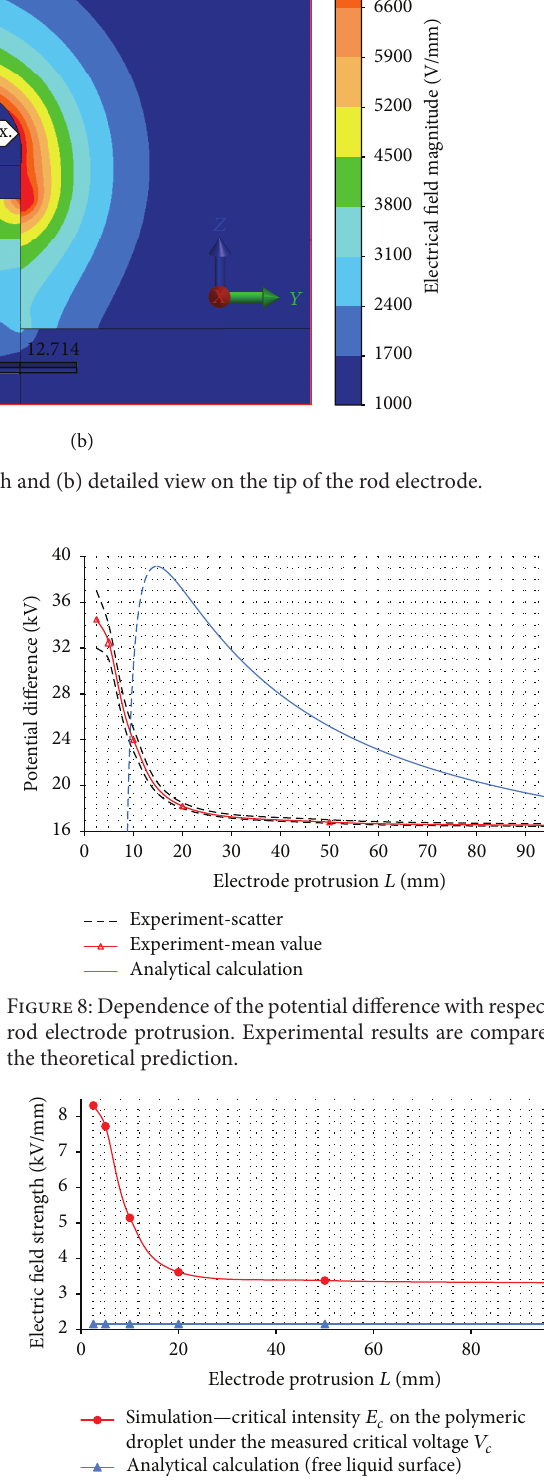
Figure 9: Dependence of the critical electric field strength on the rod electrode